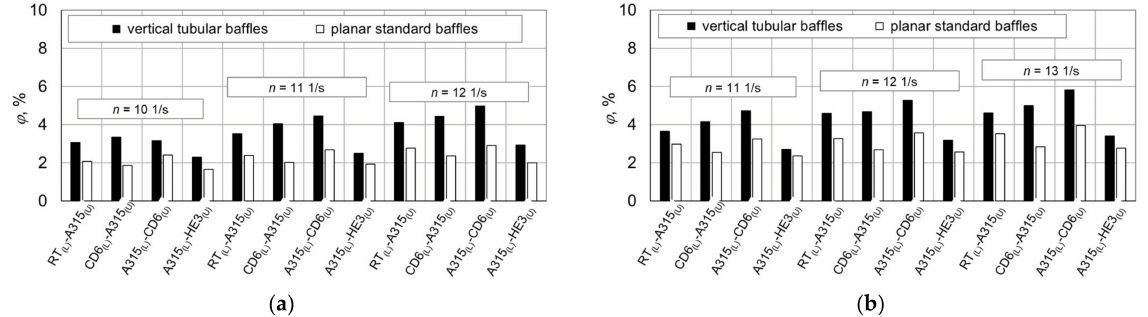
Figure 11. Dependence of ϕ = f(configuration of impellers), for different n ; w og = 3.413 × 10 − 3 m/s;